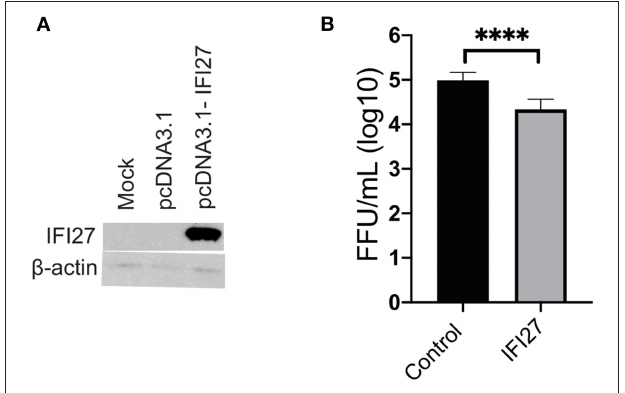
FIGURE 8 | IFI27 overexpression reduces ZIKV replication in vitro. (A) To confirm IFI27 protein expression 100 µ g of pcDNA3.1 or pcDNA3.1-IFI27 DNA was transfected into HEK293 cells. At 7h post-transfection cell lysates were analyzed for IFI27 or actin by western blotting. (B) HEK293 cells were transfected with 100 µ g of a control vector constitutively expressing GFP or pcDNA3.1-IFI27 24h post-transfection cells were infected with ZIKV (MOI = 1). At 72 hpi supernatants were collected and virus quantified by focus forming assay. P values were determined by paired student’s t -test **** p < 0.0001,